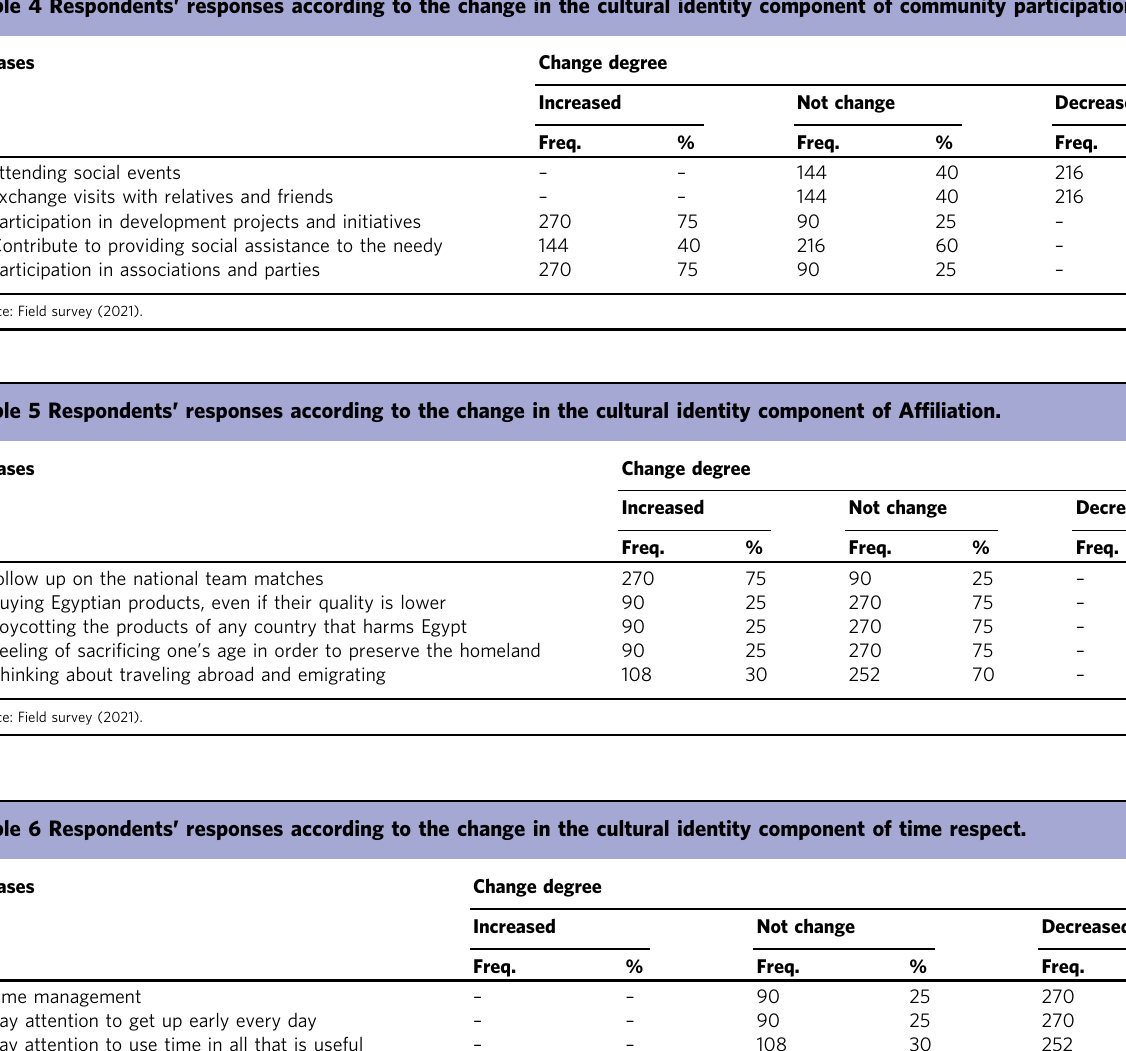
Table 4 Respondents ’ responses according to the change in the cultural identity component of community participation.